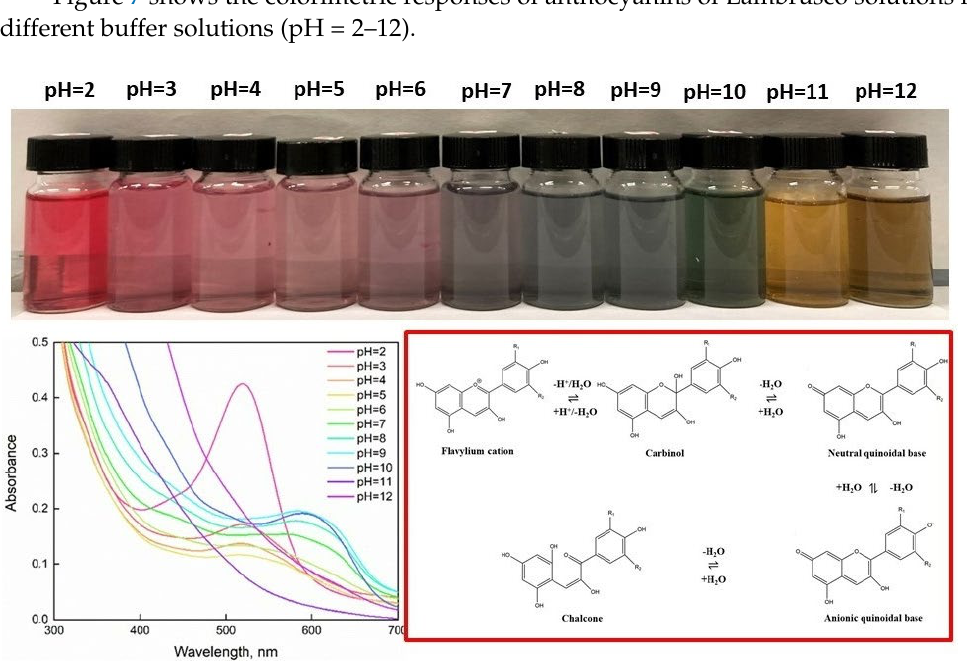
Figure 7. Color variations of Lambrusco GP-derived anthocyanins in different buffer solutions of different pH (2–12).